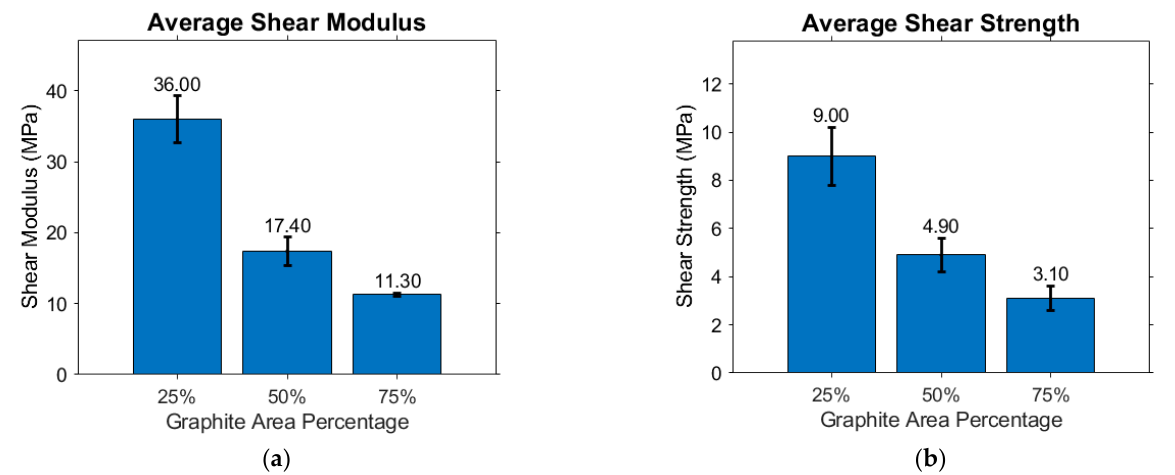
Figure 7. Specimens welded using “hold” controls with varying graphite coverage and resulting ( a ) average shear modulus and ( b ) shear strength. ( a ) average shear modulus and ( b ) shear strength.